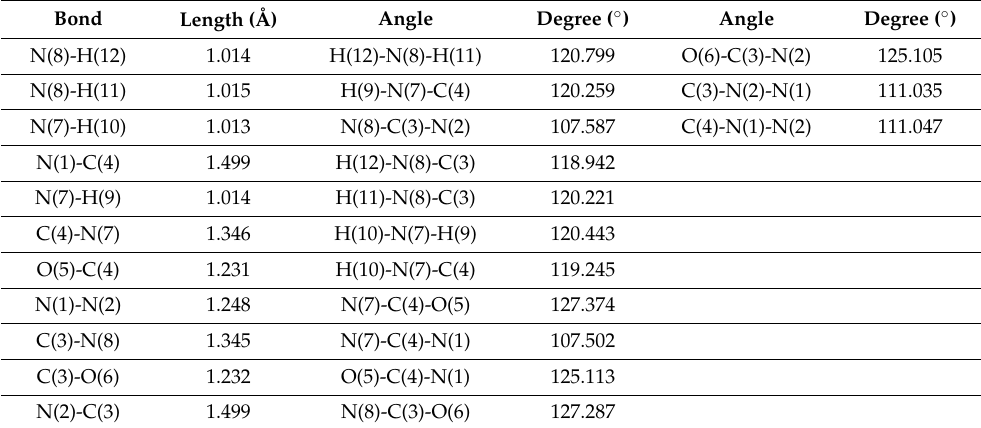
Table 6. Selected bond lengths (Å) and bond angles ( ◦ ) of (Ligand) ligand using DFT-method from DMOL 3 calculations.